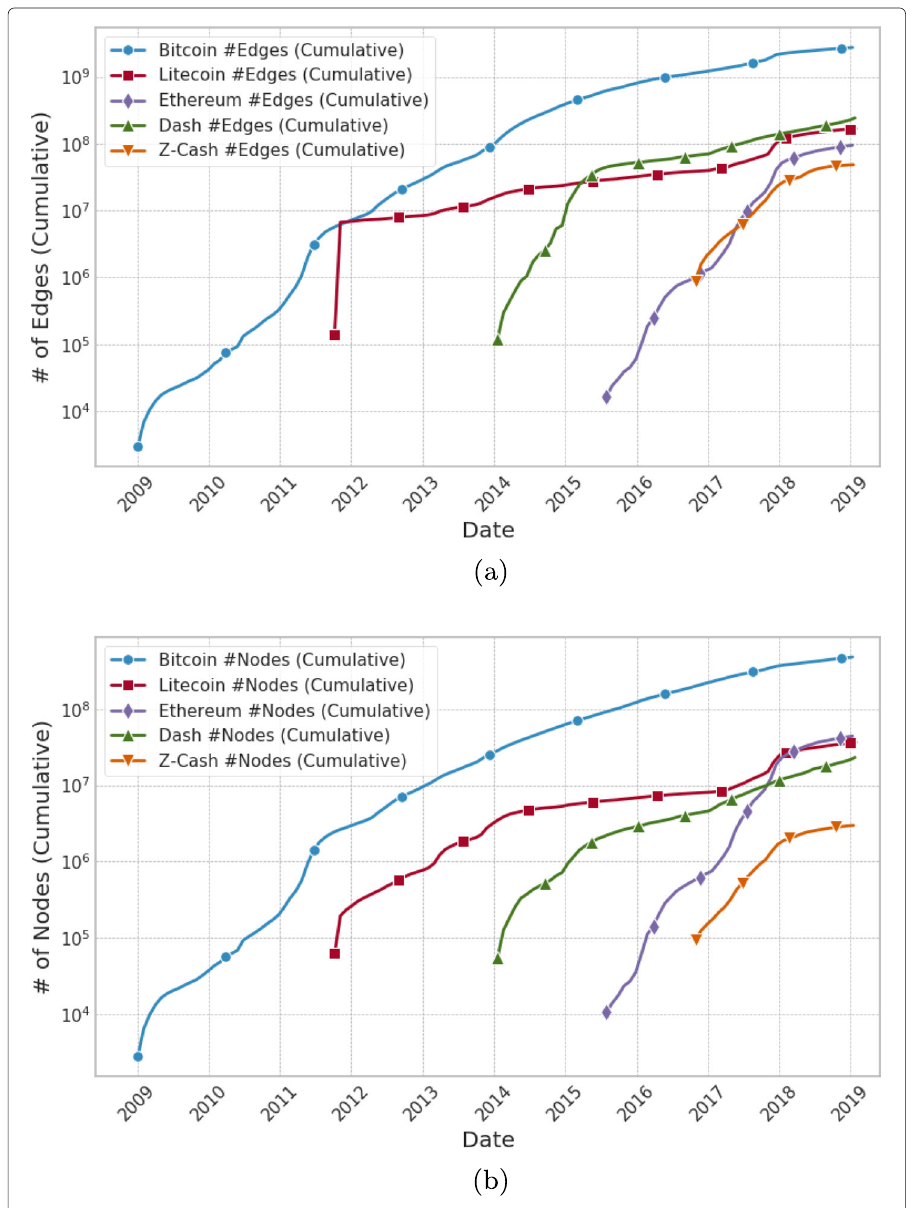
Fig. 3 Size of CMTG graph over time. a Number of edges. b Number of nodes